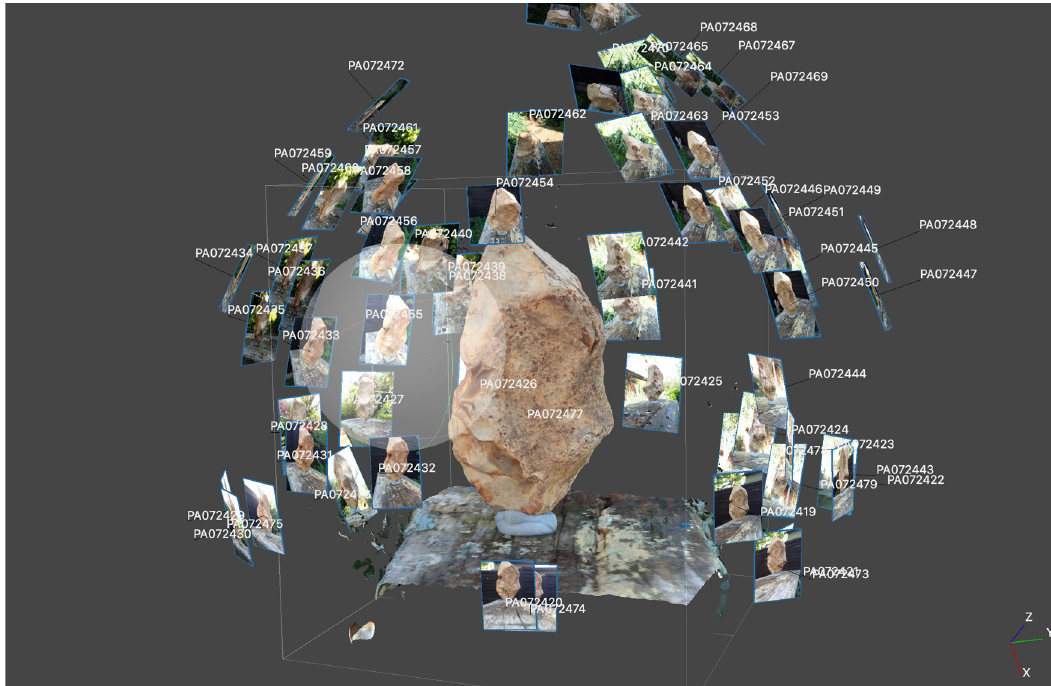
Figure 7: Screenshot of SfM Mesh bubble with